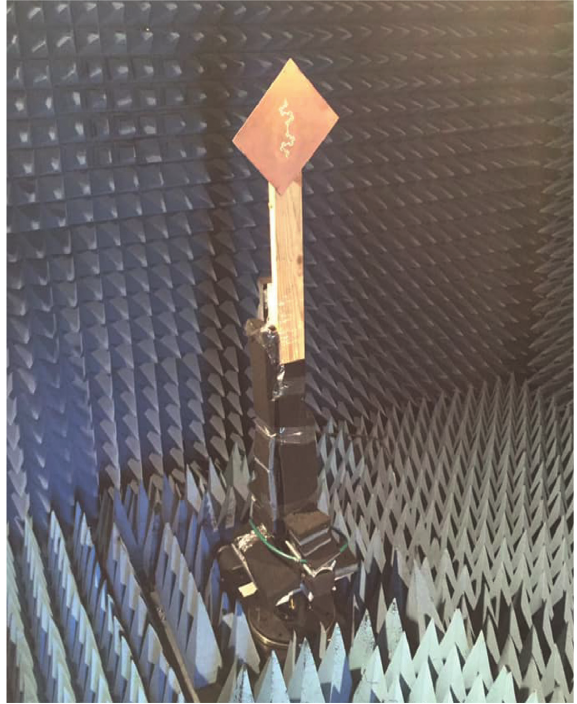
Figure 4: The second-iteration fractal slot antenna mounted when measured inside the anechoic chamber.